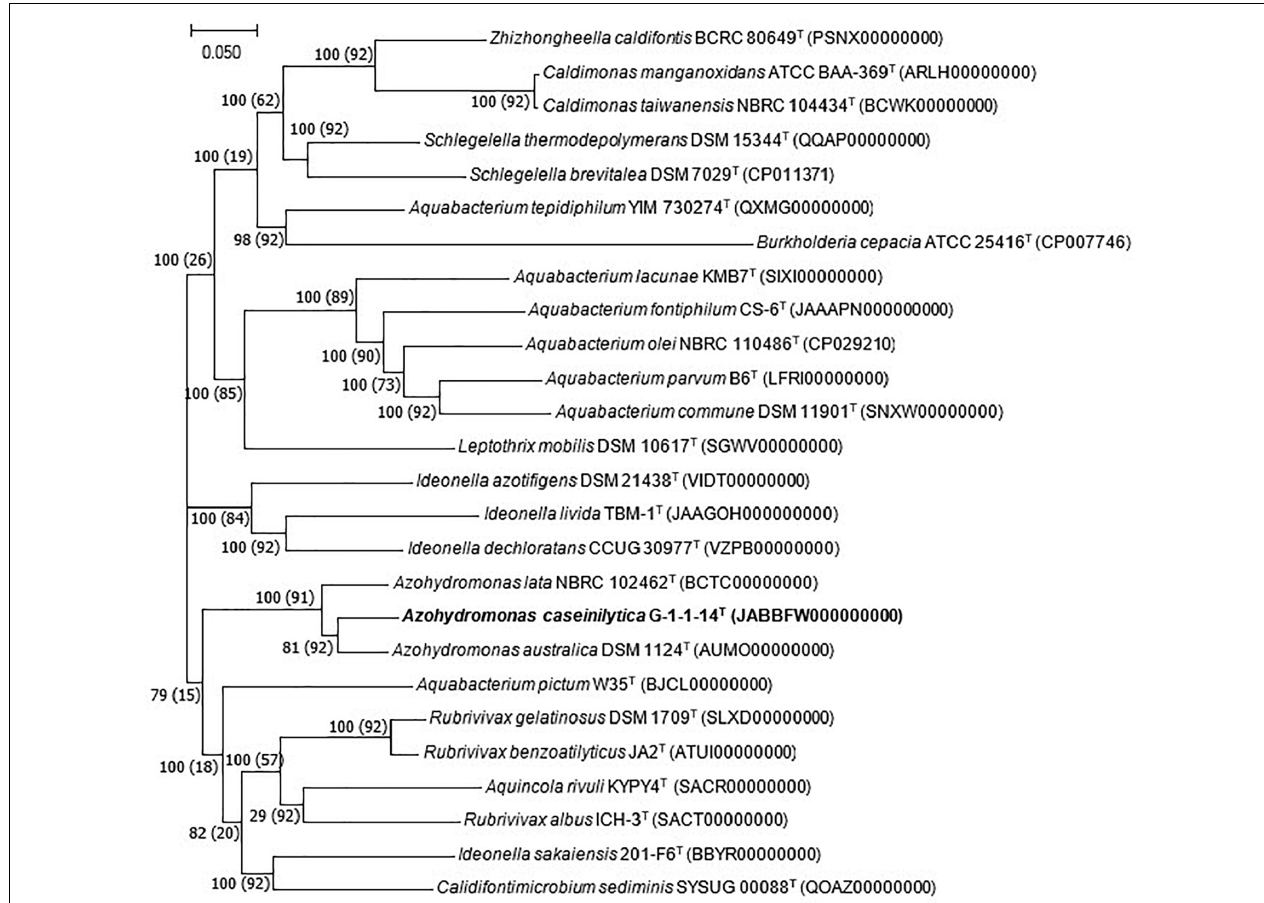
FIGURE 2 | Phylogenomic tree based on the concatenated alignment of 92 core genes. Bar , 0.050 substitution per nucleotide position. Bootstrap and gene support index (GSI) values are shown in the branch nodes . Values in parentheses are GSI. Bold values indicates proposed species.